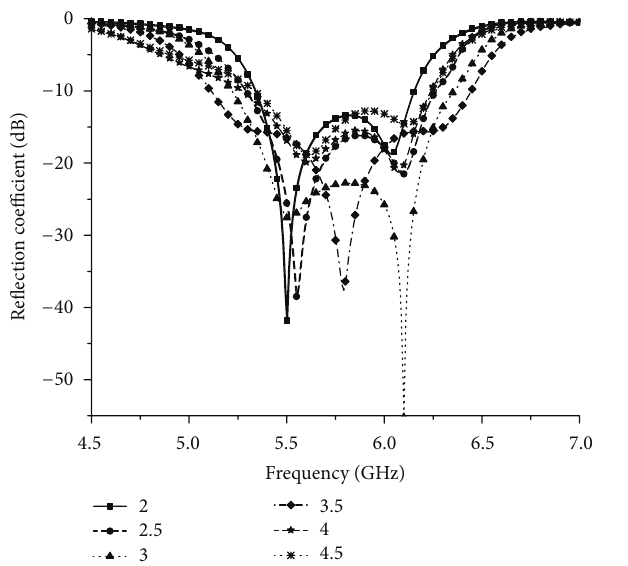
Figure 7: The simulated reflection coefficient of the different fractal proportion.